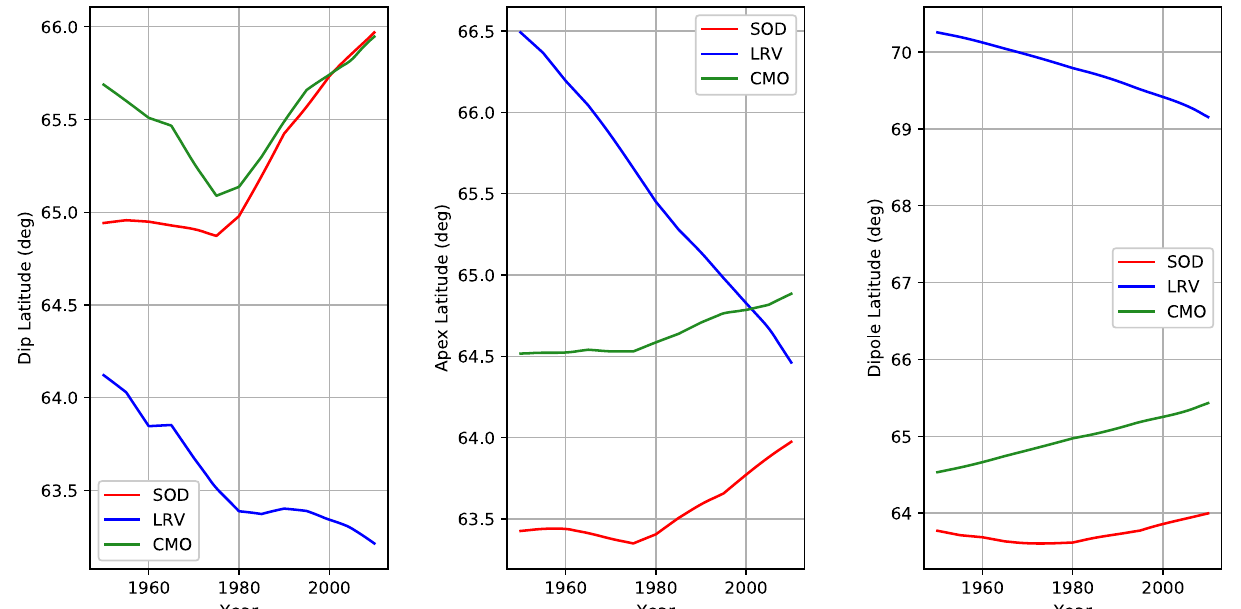
Fig. 3. Dip latitude (left), apex latitude (middle), and dipole latitude (right) of ground-based magnetometers at SOD, LRV,